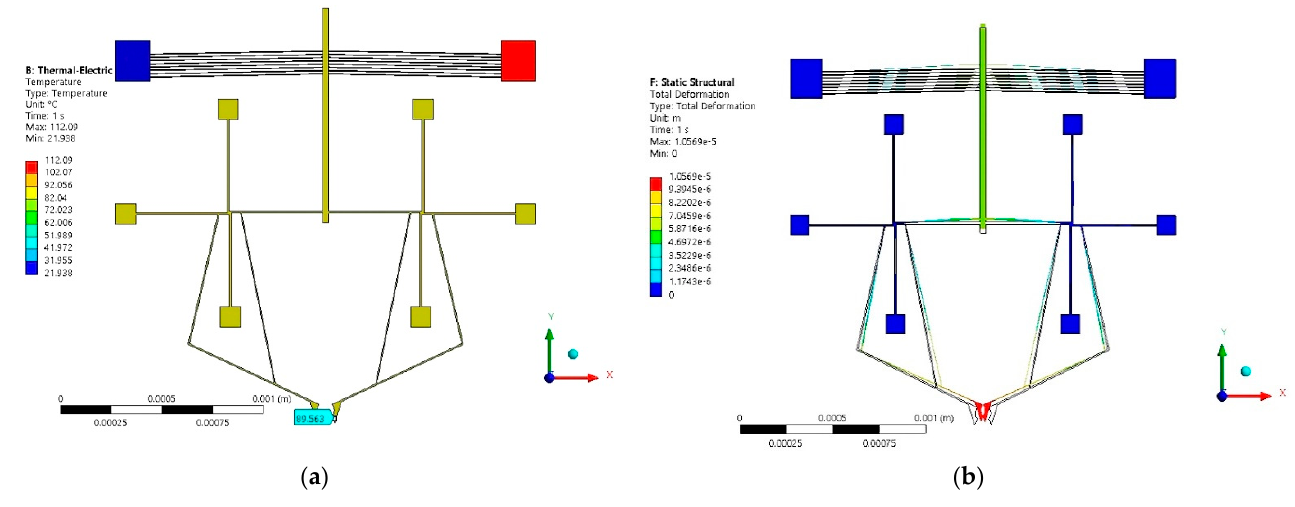
Figure 12. Microgripper Model 2: ( a ) temperature distribution and ( b ) displacement at 2 V.